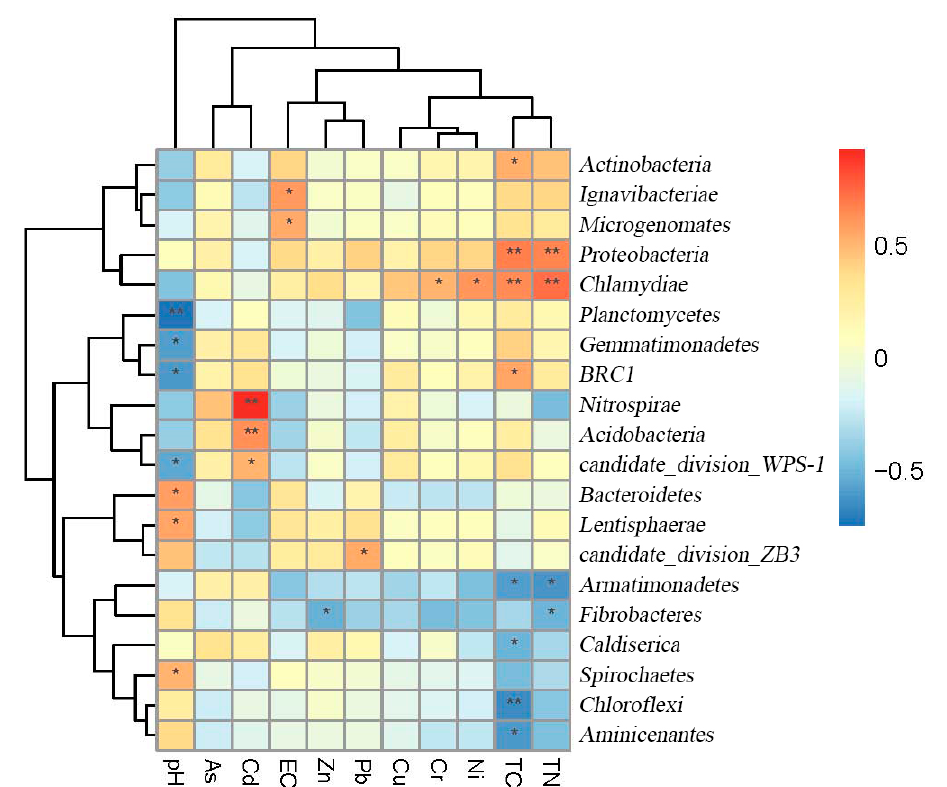
Figure 5. Effects of environmental factors on the community structures of dominant bacteria at the phylum level by Spearman’s correlation analysis. Note: the figure shows the correlation between environmental factors and microorganisms with a warm tone indicating positive correlation and cool tone indicating a negative correlation. (* indicates 0.01 < p ≤ 0.05, ** indicates 0.001 < p ≤ 0.01).